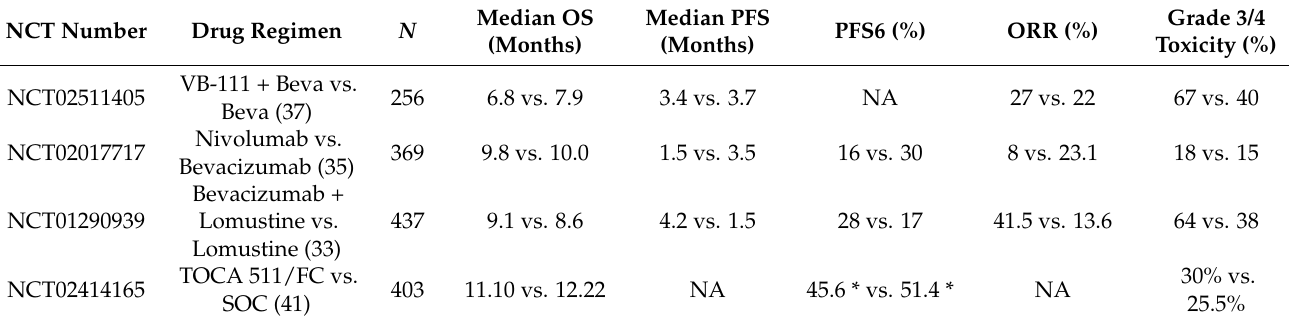
Table 2. Recent major phase III studies in rGBM